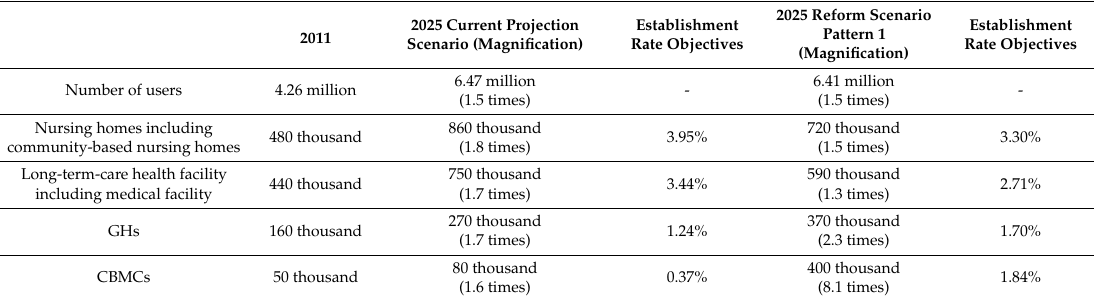
Table 5. Prospective number of users of elderly care facilities from the article “Issues related to a review of the system of the elderly care in regard to social insurance and tax integration reform”